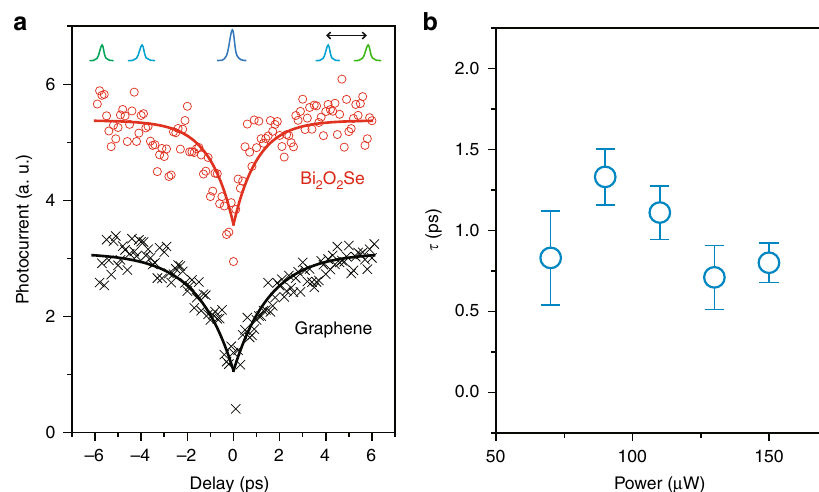
Fig. 3 Time-resolved photocurrent spectroscopy of 2D Bi 2 O 2 Se photodetector. a Photocurrent as a function of delay time between two ultrafast pulses (~100 fs) at zero bias voltage. The red circles and black crosses are data of Bi 2 O 2 Se and graphene photodetector, while solid lines are exponential fi tting. The blue and green curves in the top of the fi gure represent pump and probe laser pulses, while the black arrow shows the delay time between these two pulses. When delay time is too short, the excitation of the fi rst pulse does not have enough time to turn into current before it meets the excitation of the second pulse, which induces sublinearity in photocurrent and reaches a dip at zero delay. When delay time is long enough, excitations from the two pulses perform independently and result in largest voltage, which is used for normalization value in this chart. b Response time ( τ ) of Bi 2 O 2 Se photodetector measured at different incident pump power. The response time is de fi ned as time constant τ in exponential fi tting of the photocurrent – delay curve by equation 3. Error bars here describe standard errors of the fi tting